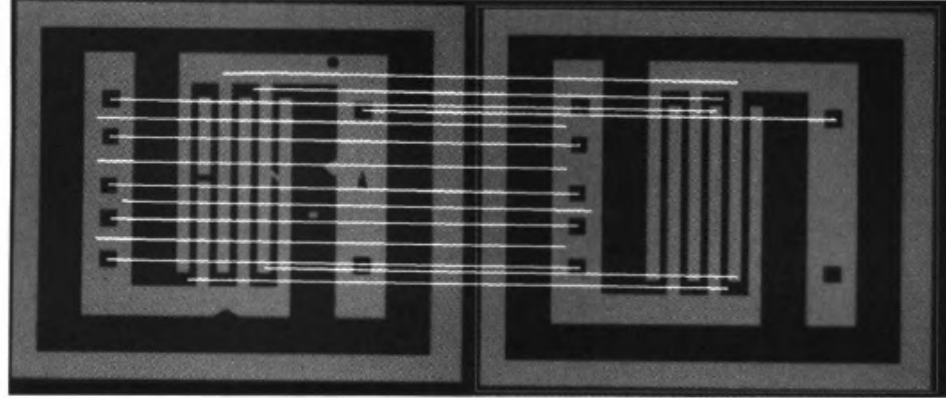
Figure 7. The feature point matching result between the test image and the standard image.